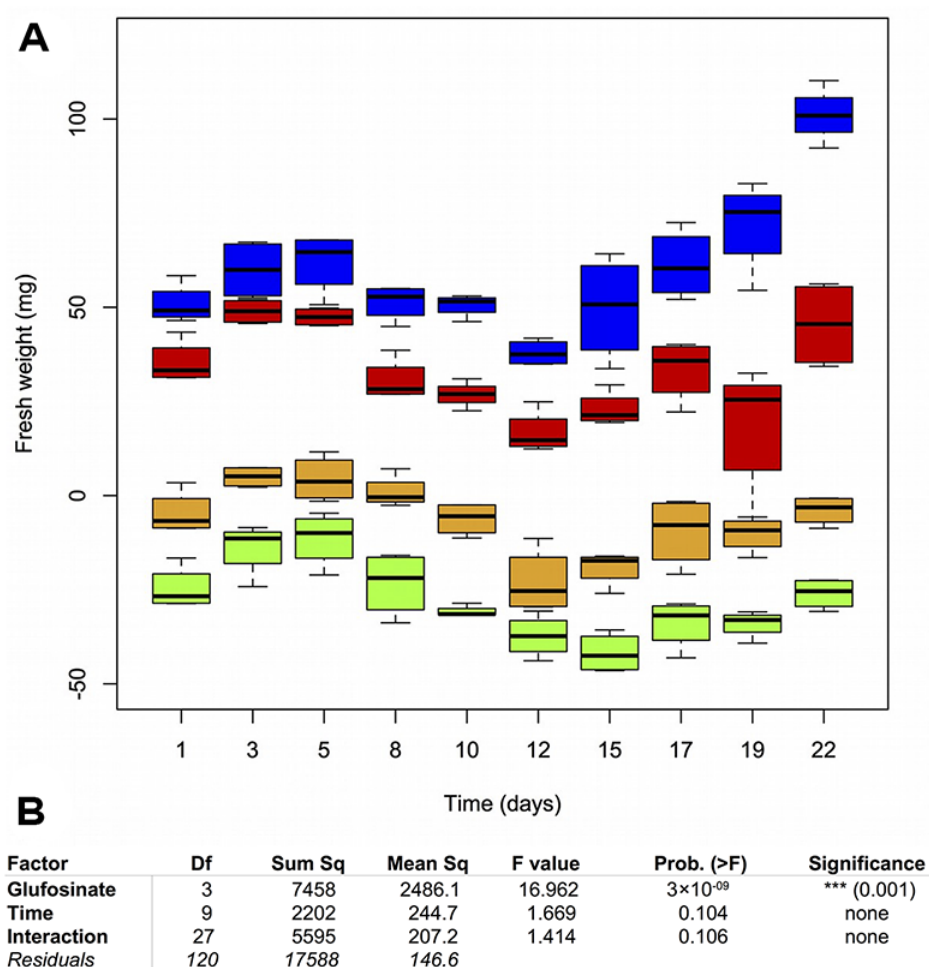
Fig. 3 Box–Wilson plots of the mass ( A ) of 1-mL samples of C. annuum ‘Serrano’ cell suspensions measured against cultivation time in solid medium MS-B5 and in the absence (blue bars) or presence of glufosinate at 2 (red; offset 1 −15), 4 (yellow; offset 1 −55), or 8 (green; offset 1 −75) mg L −1 . 1 For clarity, the plots for data in the presence of glufosinate were offset down, as indicated. The results from a two- way ANOVA are shown below ( B ) (*** significant differences at p < 0.001 apply to glufosinate factor globally). The plot and ANOVA were performed using R statistical software [32]. The average dry weigh was 5.03 ±1.22% of the fresh weight, and remained stable along the